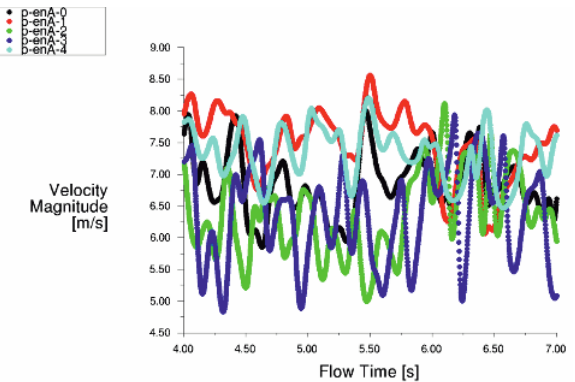
Figure 9: Velocity behavior in front of metering run branching